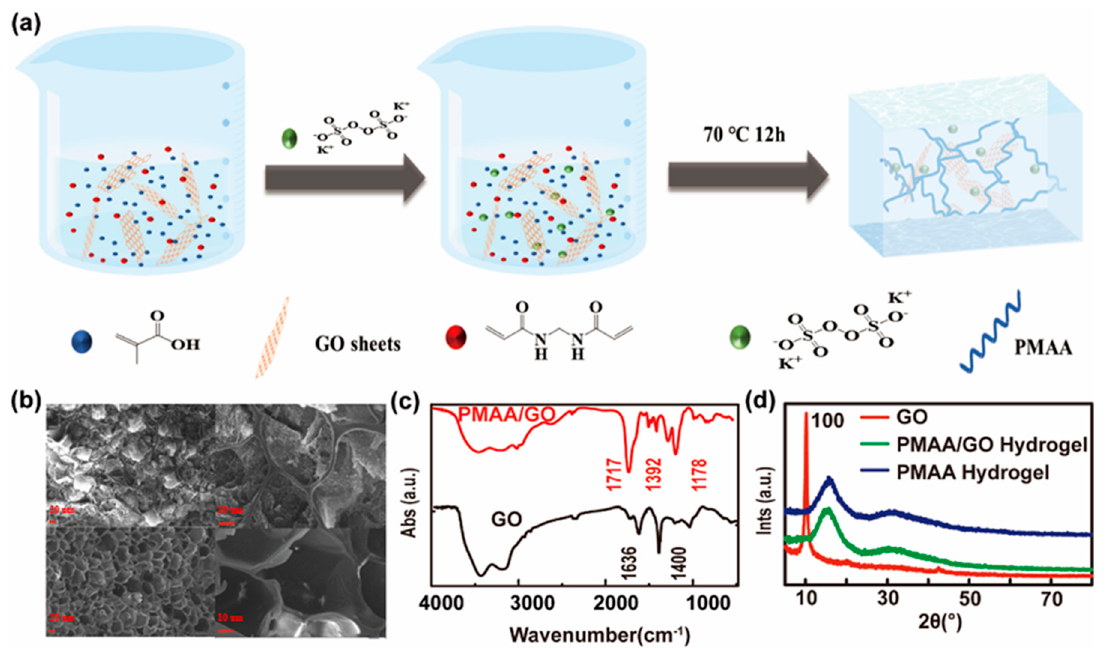
Figure 1. Scheme of synthesis and characterization of poly(methacrylic acid) (PMAA)/graphene oxide (GO) hydrogel. ( a ) Synthesis scheme of PMAA/GO hydrogel. ( b ) SEM images of PMAA and PMAA/GO nanohybrid hydrogel. ( c ) FTIR of PMAA/GO nanohybrid hydrogel and GO. ( d ) XRD patterns of GO, PMAA hydrogel, and PMAA/GO composite hydrogel. Scale bars are 10 μ m and 20 μ m.